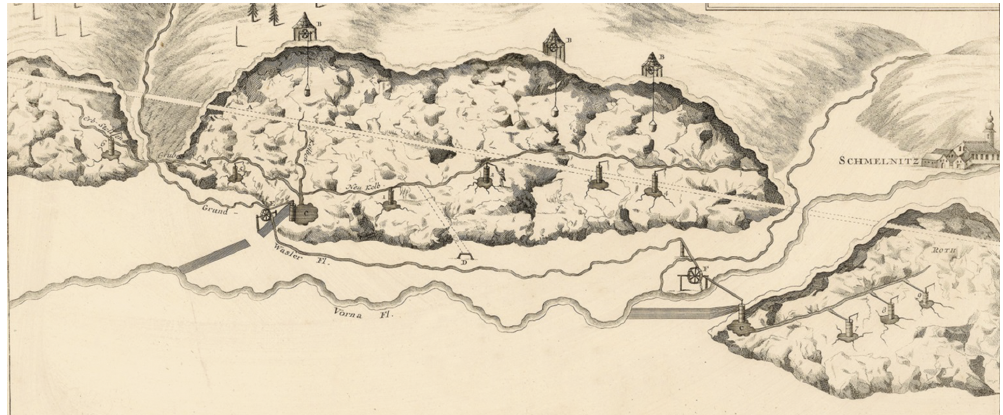
Figure 2. The oldest view of the mines in Smolník on the map of Luigi Ferdinand Marsigli from 1696, published in print under the title Fodinae Schmelnitzences (Mines of Smolník) . The map shows a cross section of the Smolník deposits, with a detailed view of mining of cementation water in the underground (source: the State Central Mining Archives in Banská Štiavnica, Slovakia; photo was taken in 2015).